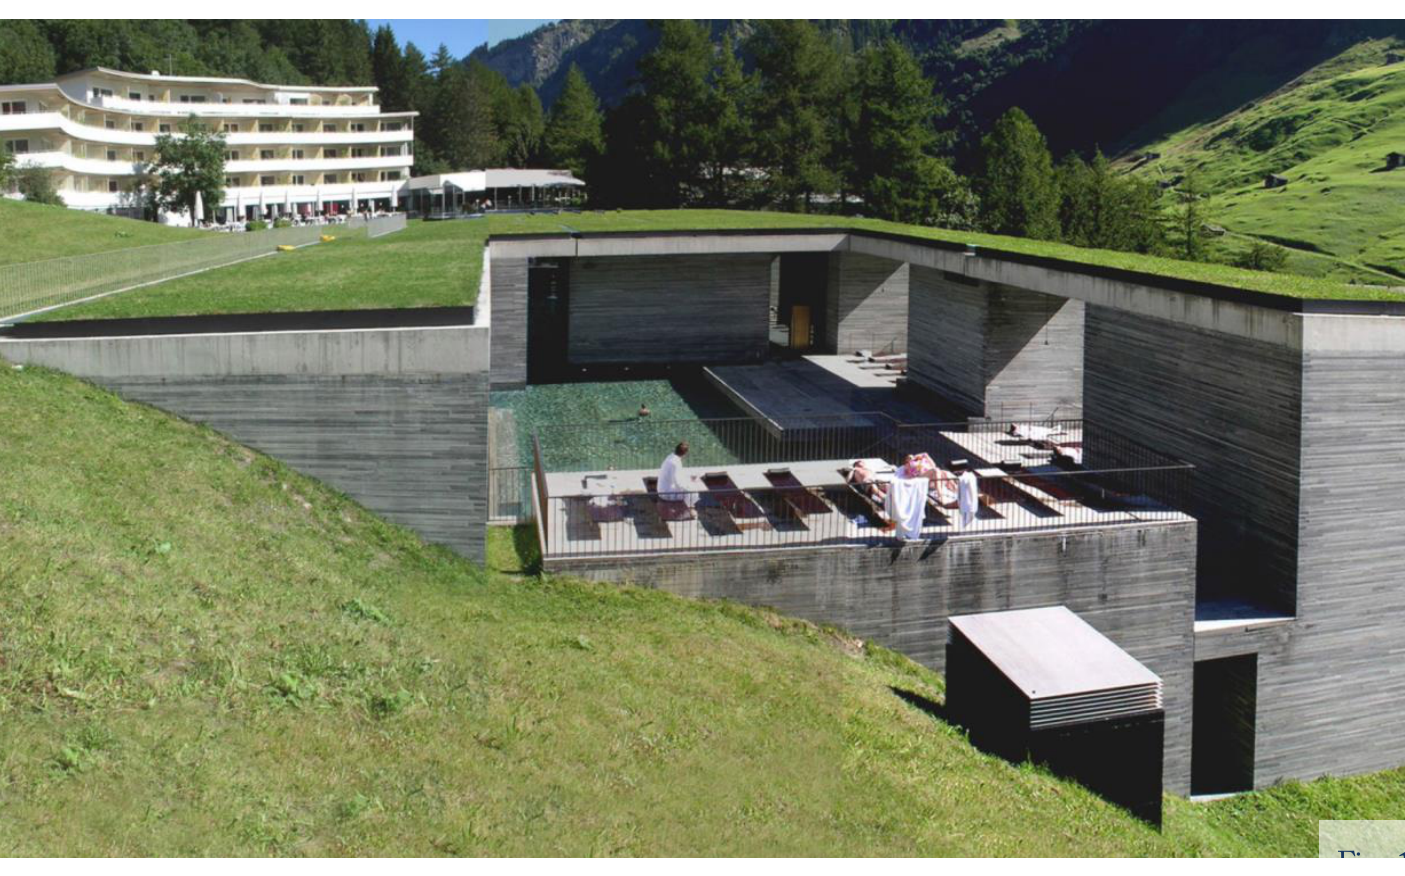
Figure 14. Exterior view (Unknown, 1996). From: